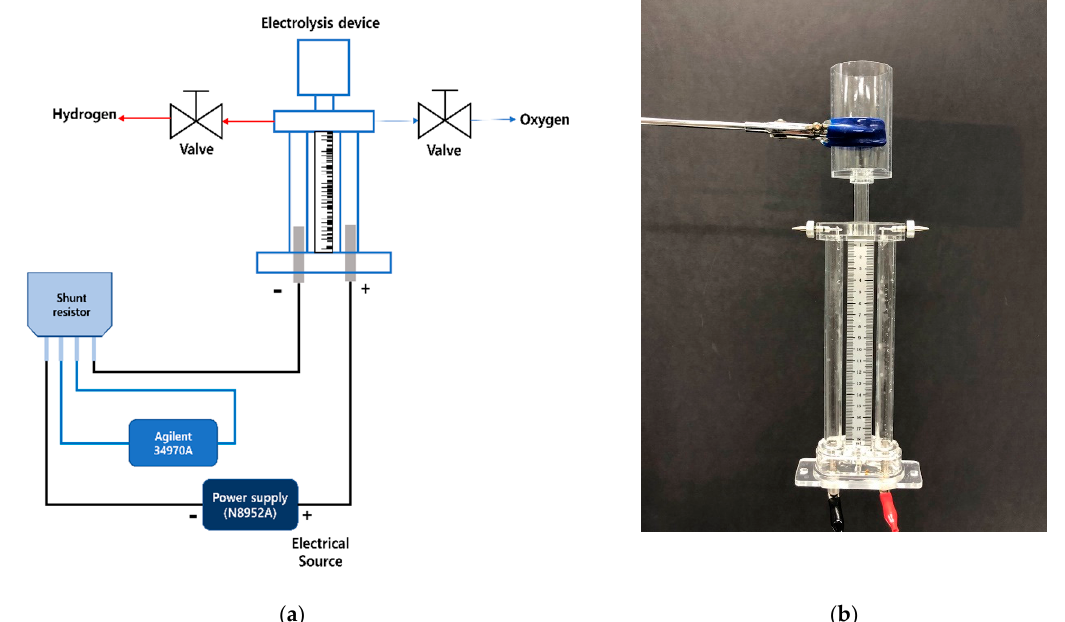
Figure 1. Hofmann electrolysis apparatus ( a ) schematic ( b ) picture.